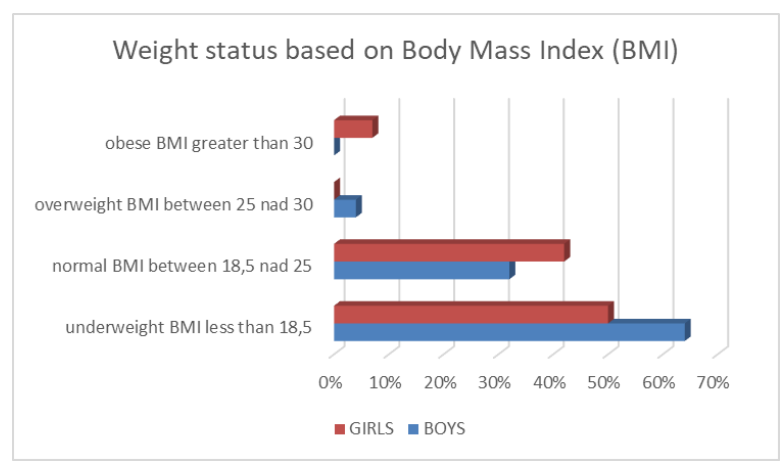
Figure 2. Distribution of percentiles for body mass index (BMI) .